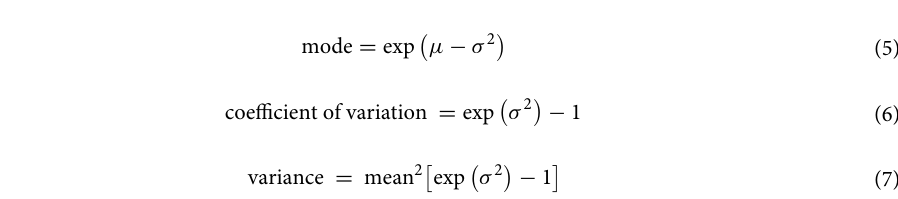
Figure 4. Relationship between the cumulative pore size distribution and P/C ratio of epoxy latex-modified mortar at different ages, ( a ) 7, ( b ) 14, ( c ) 28, and ( d ) 90